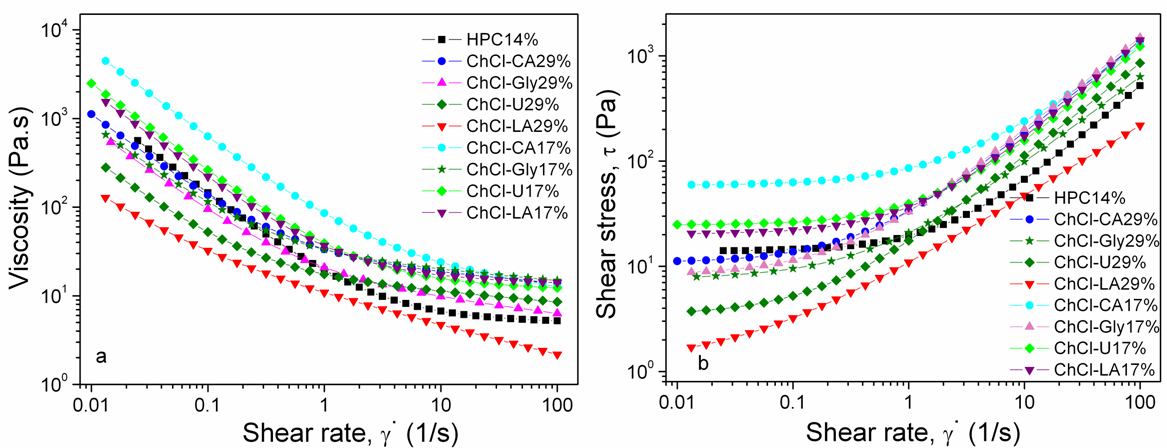
Figure 9. The flow behavior of the HPC (solution 14%) and HPC-based NADES gels (17% and 29%): viscosity ( a ) and shear stress ( b ). viscosity ( a ) and shear stress ( b